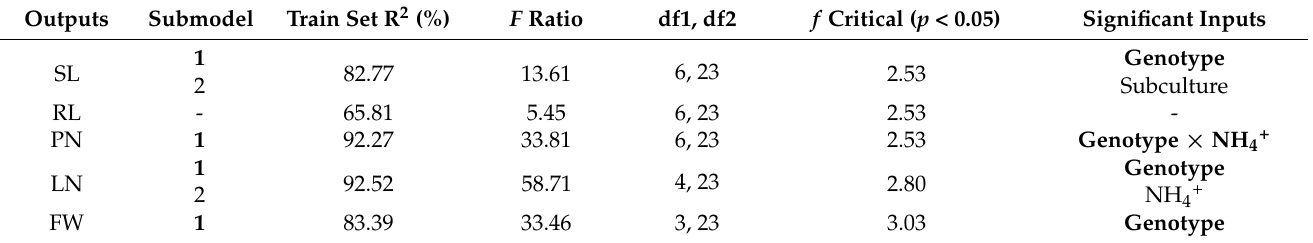
Table 2. Neurofuzzy logic model quality parameters and inputs with a significant effect on each output. Inputs with the strongest effect on each parameter are shown in